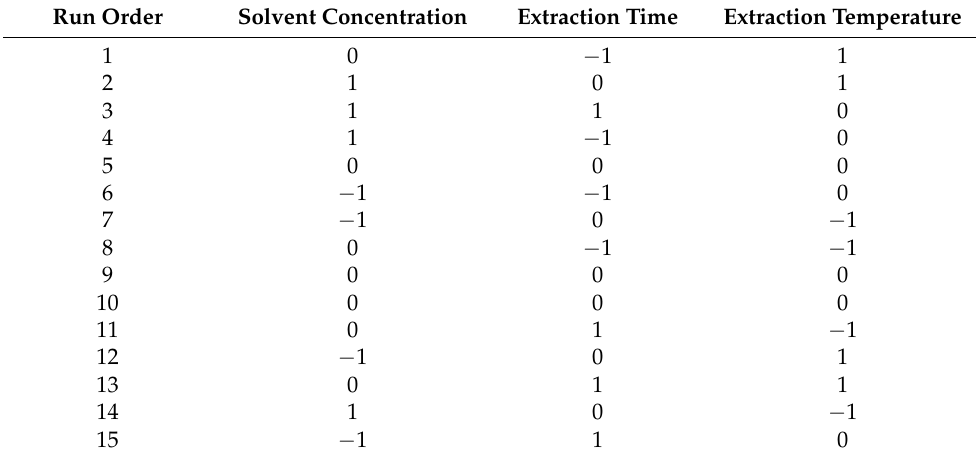
Table 2. Box–Behnken design for the three independent variables (coded) for CA extraction from D. morbifera